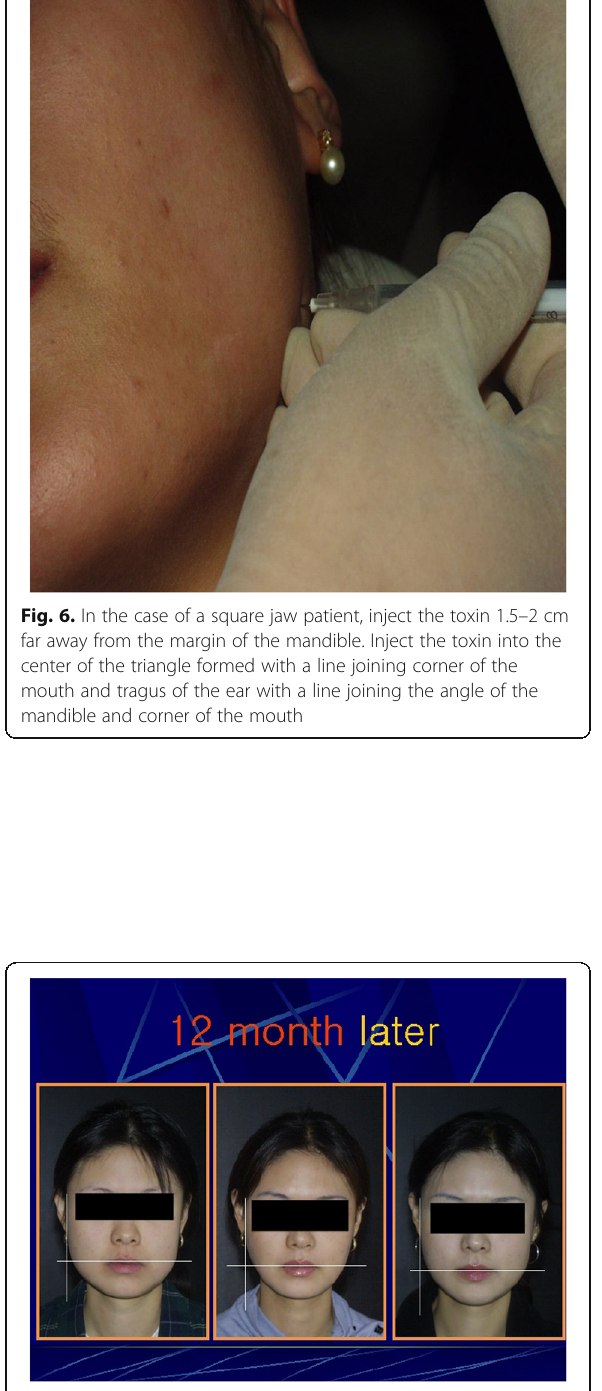
Fig. 7 Picture in the left is before the injection, picture in the middle is after 6 months of injection, and picture in the right is after 12 months of injection. The therapeutic effect was greatest at 6th month, and even though there was a bit of regression phenomenon at 12 month compared with the initial picture one can able to continuously observe contraction of the masseteric muscle. It is possible to determine the timing of the second